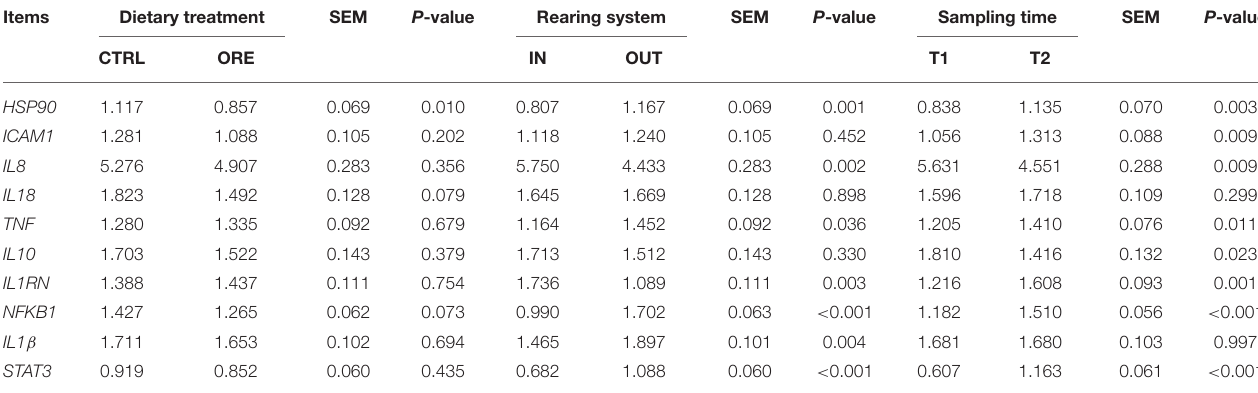
TABLE 5 | Diet, farming system, and time effects on gene expression. Items